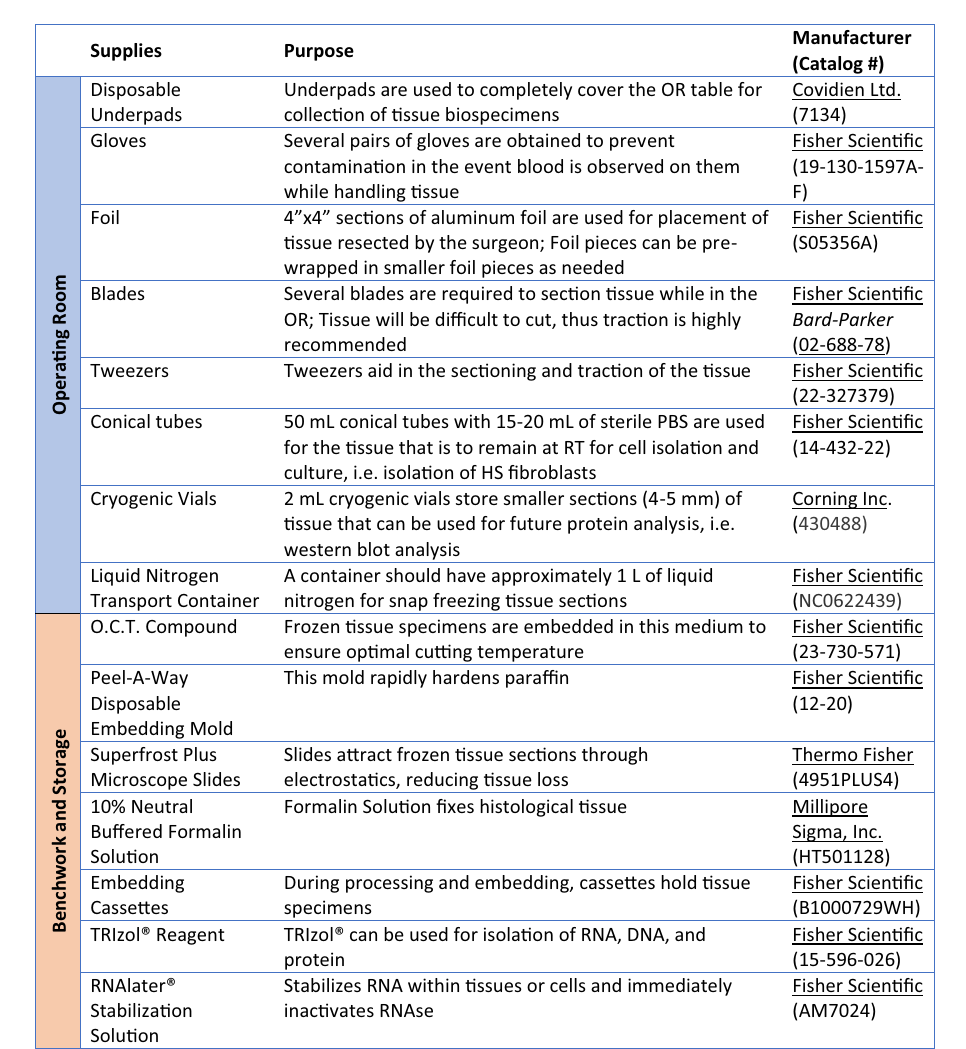
Figure 4. Supplies for operating room, benchwork, and storage. Listed are the supplies necessary for the operating room, benchwork, and storage when working with HS biospecimens as well as their purpose and manufacturers.